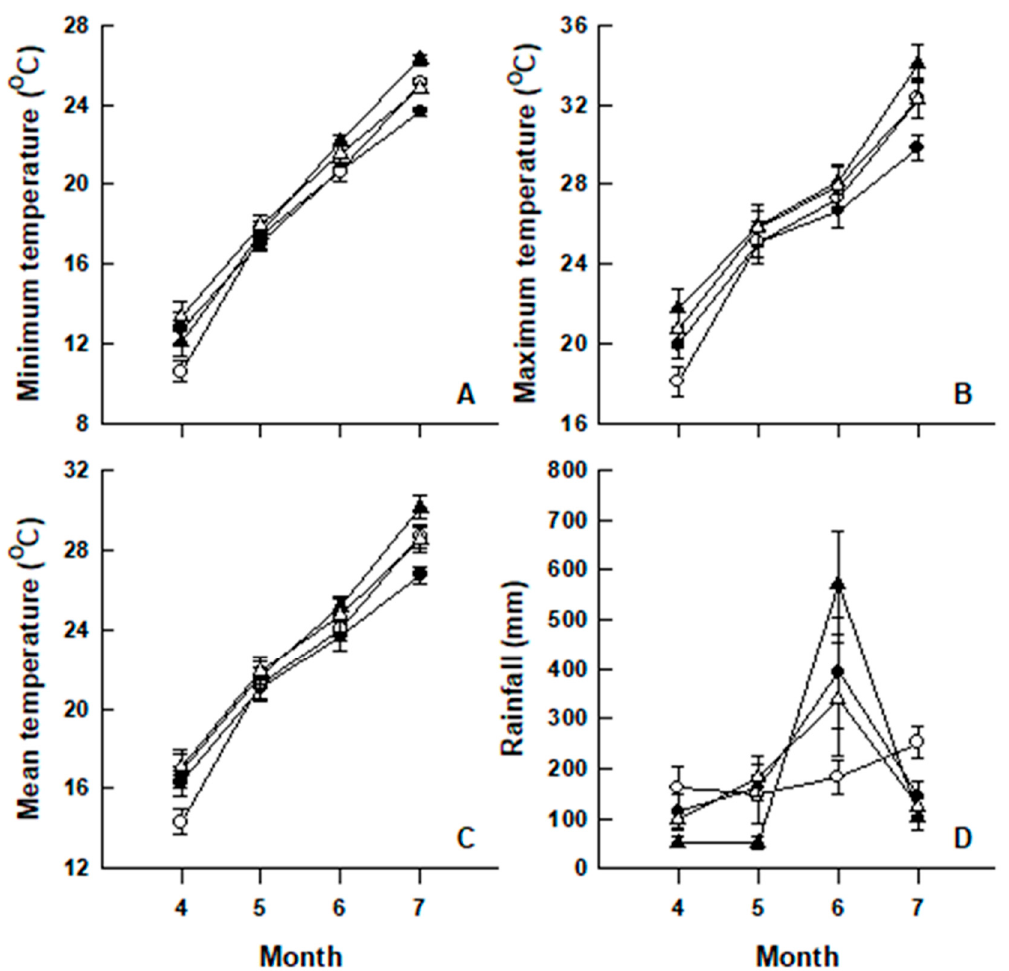
Figure 1. Mean values ( ± SE) for monthly minimum ( A ), maximum ( B ) and mean ( C ) air temperatures and rainfall ( D ) over a four-month period from April to July in 1999 ( • ), 2010 ( ( (cid:52) ) (http://www.cma.gov.cn; accessed on 28 February